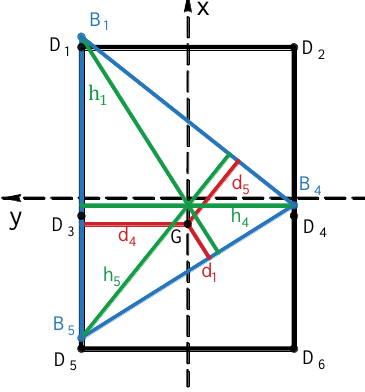
Figure 5. Structure diagram of the hydraulic hexapod robot (HHR).